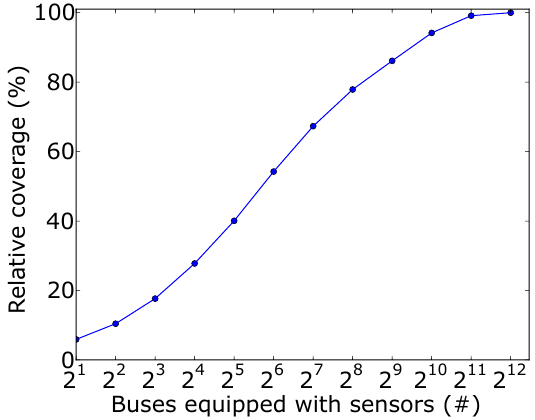
Figure 4. Relative coverage of the buses equipped with